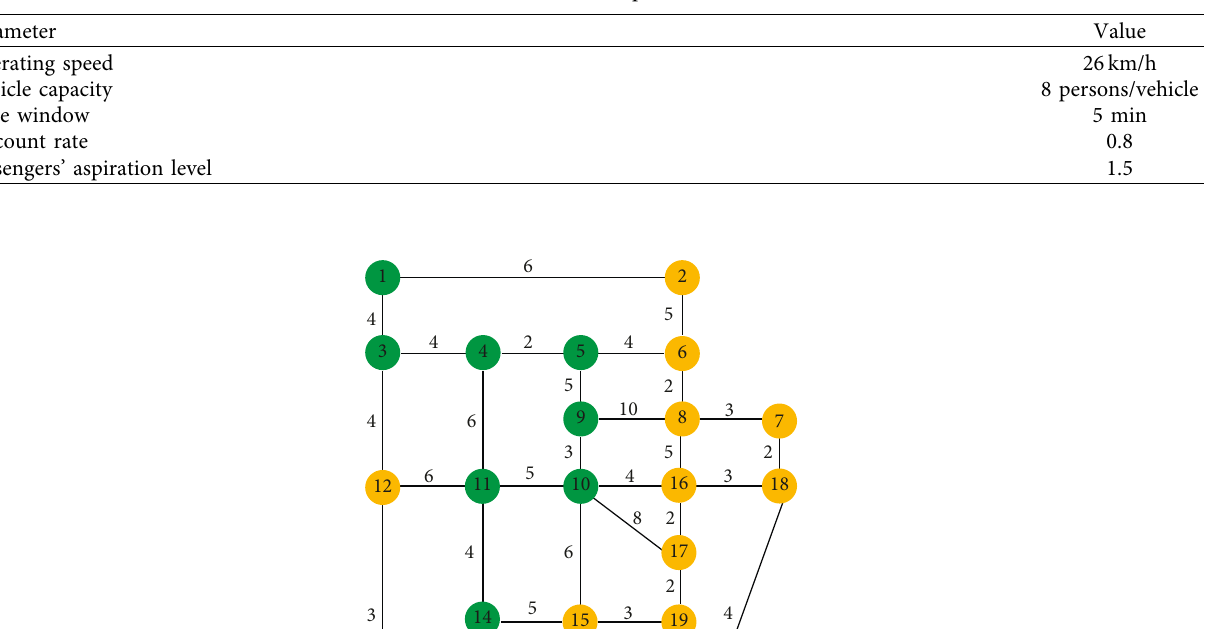
Table 3: The value of parameters.